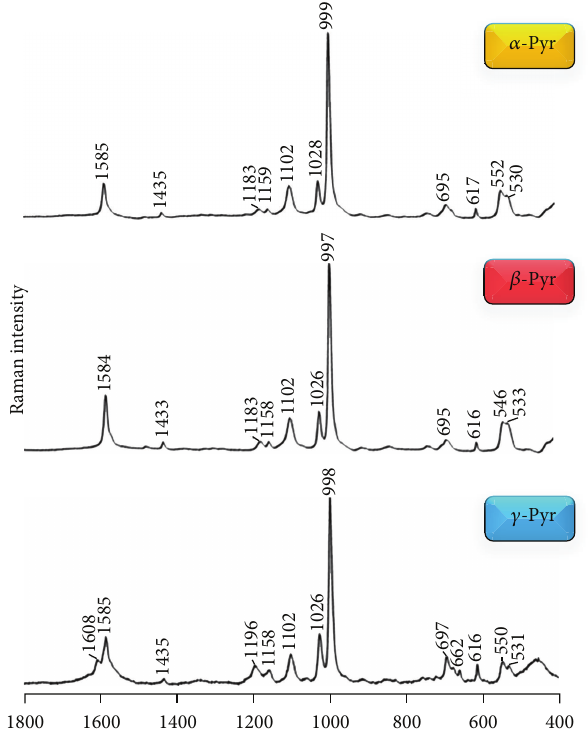
Figure 2: The SERS spectra of 𝛼 -Pyr, 𝛽 -Pyr, and 𝛾 -Pyr adsorbed onto colloidal gold